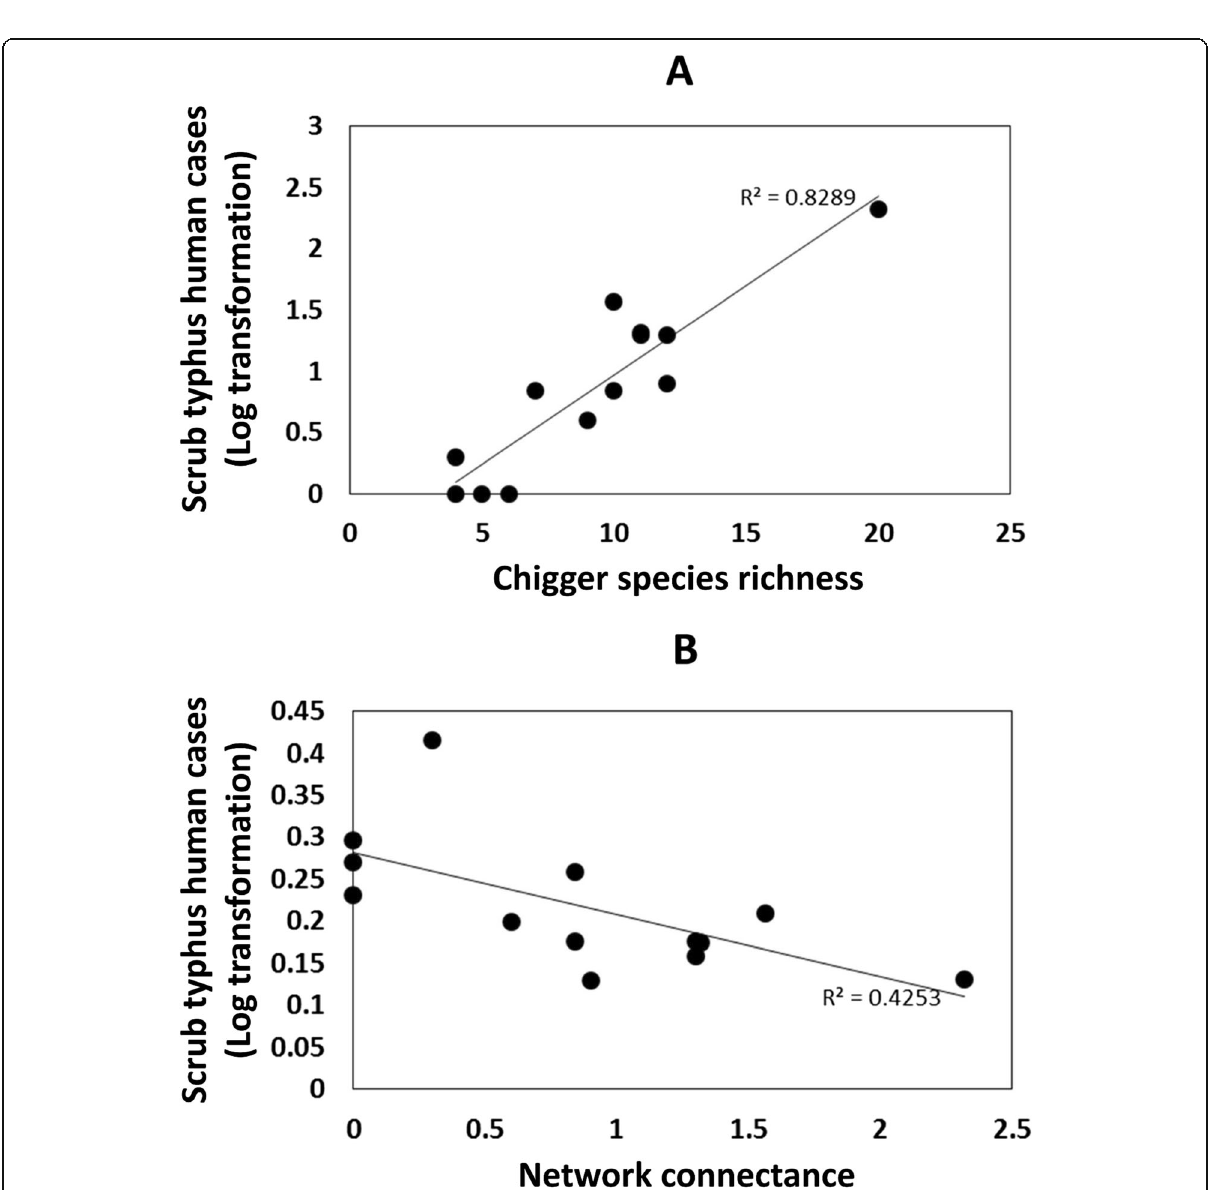
Fig. 4 Correlation plots show the relationship between chigger ecology [( a ) chigger species richness; ( b ) host-chigger network connectance] and scrub typhus incidence in humans. Incidence data are displayed as the log 10 transformation of the number of cases per